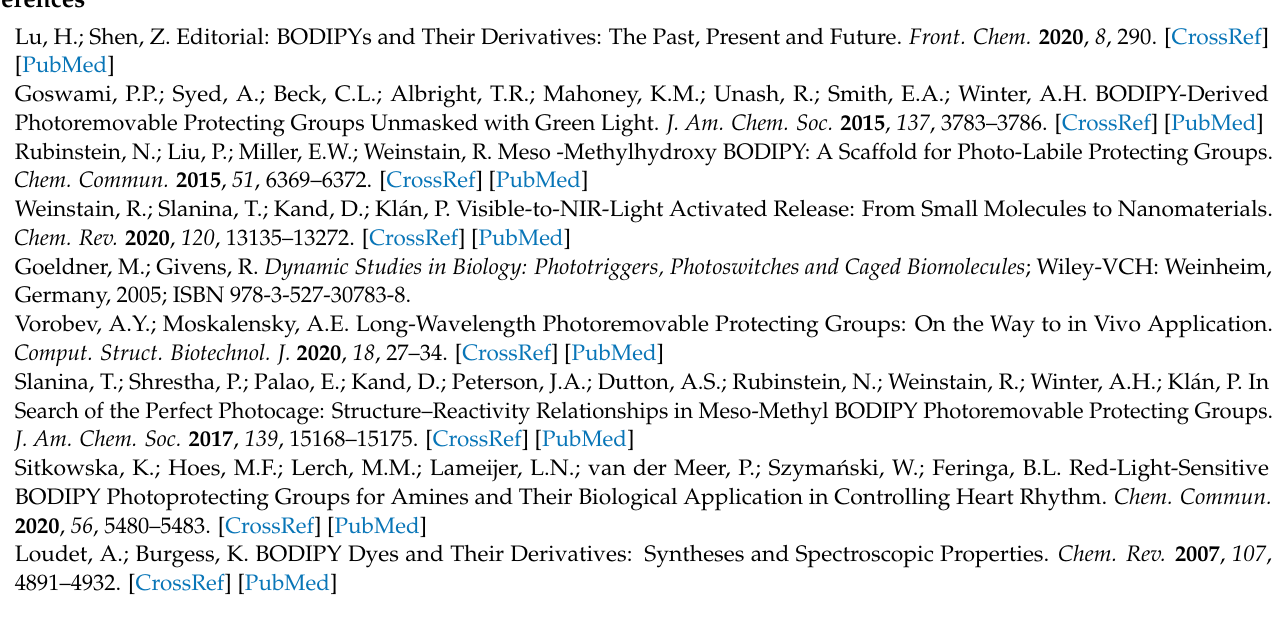
Supplementary Materials: The following are available online: copies of 1 H and 13 C NMR spectra for all isolated